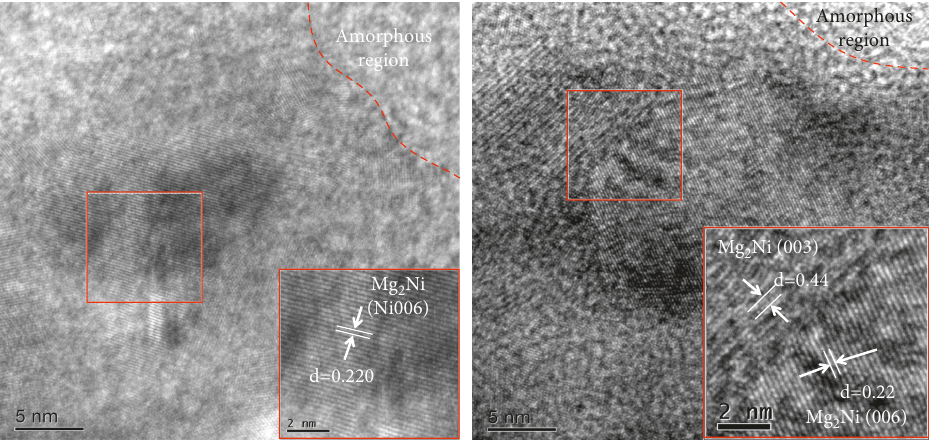
Figure 7: TEM image of HCX-2 ball milling for